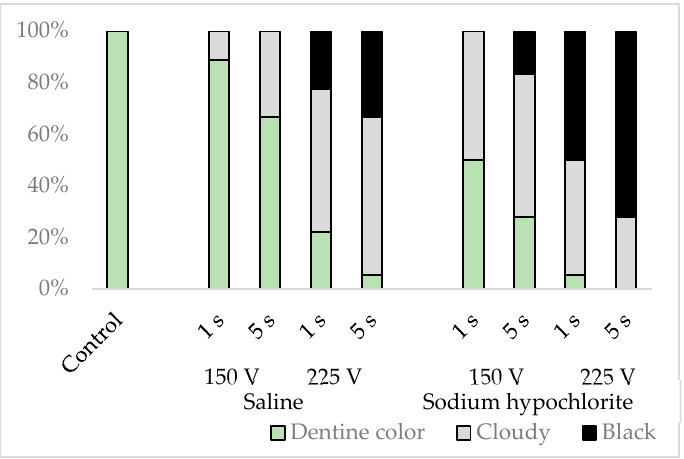
Figure 6. Classification results of simulated root canal walls by